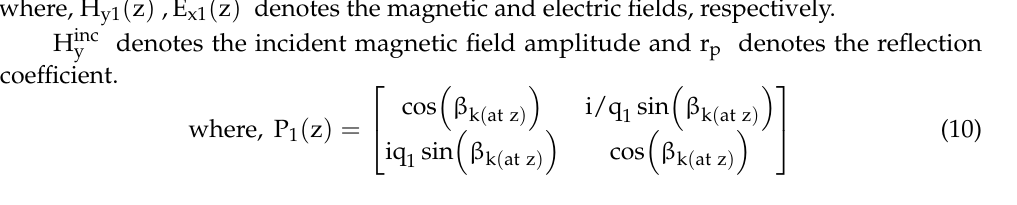
Figure 3. The electric field normal distribution and magnetic field propagation of the suggested hybrid (BK7/ Ag/ MoS 2 / MXene) SPR biosensor structure are as follows: On the surface of gold, the distribution of the electric field exhibits an amplified field at a resonance angle.